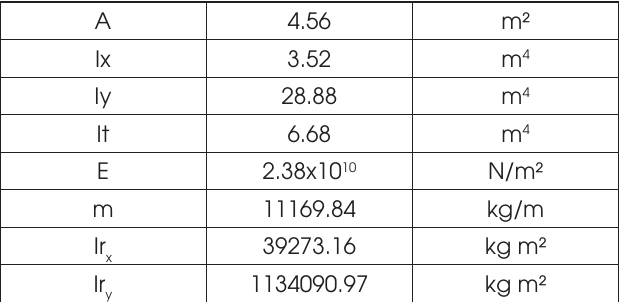
Shell-element finite-element model used for the